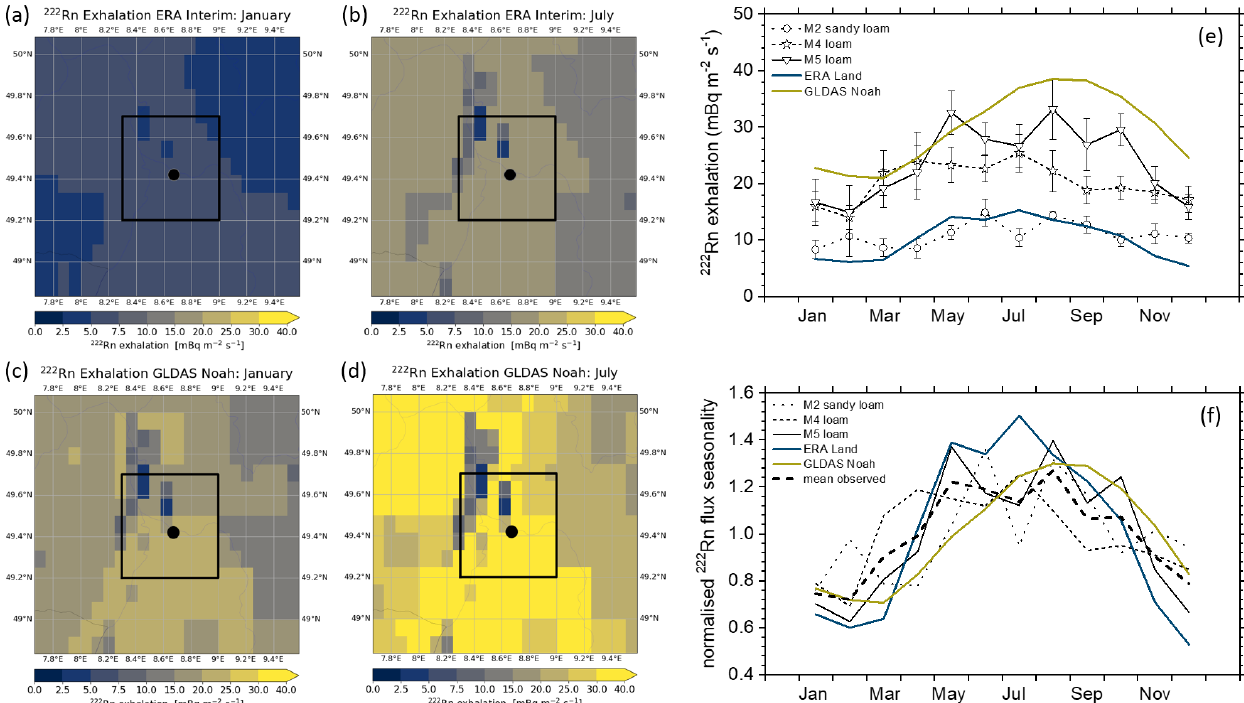
Figure 4. (a–d) 222 Rn exhalation rates as estimated by Karstens et al. (2015) for the large Heidelberg influence area based on the ERA- Interim/Land (a, b) and GLDAS Noah (c, d) soil moisture models for January (a, c) and July (b, d) . The small influence area is marked by the black rectangle with Heidelberg in its approximate centre (black dot). The very low 222 Rn fluxes north-west of Heidelberg stem from the 222 Rn flux limitation assumed in Karstens et al. (2015) based on the water table depth map by Miguez-Macho et al. (2008). (e) Mean seasonal cycle of the modelled fluxes in comparison to measurements conducted south of Heidelberg on sandy loam (M2) and loamy soils (M4, M5). Normalised (to their annual means) seasonal cycles of the fluxes shown in (e) are displayed in (f) . The mean observed 222 Rn flux seasonality is also shown as a thick dashed